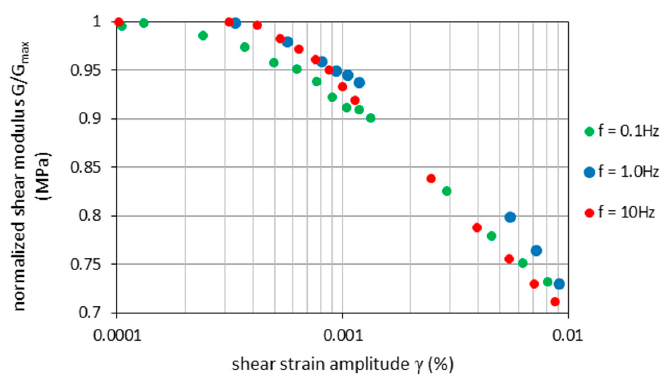
Figure 5. Normalized shear modulus G / G max versus shear strain amplitude for isotropically- consolidated RCA ( σ 3 ’ = 45 kPa) for various test frequencies.